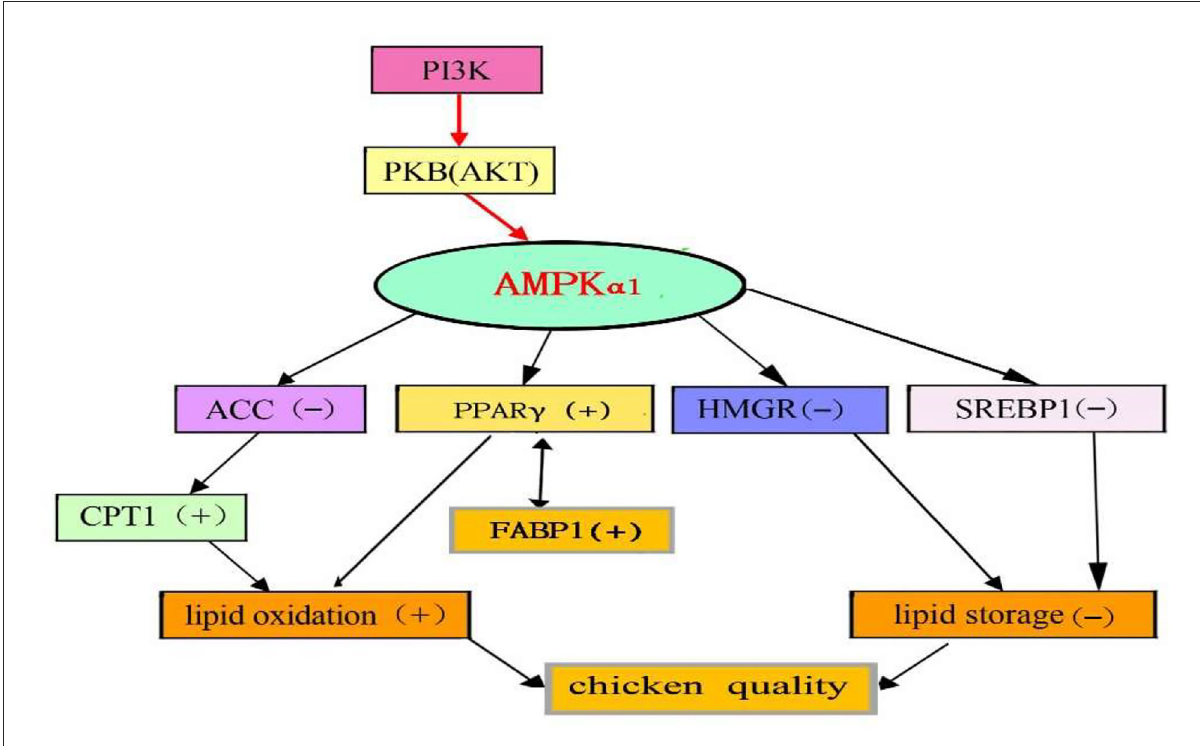
FIGURE3 Proposed model of AMPK actions on gene expressions in the breast muscle of chickens supplemented with quercetin [(–), down, ( + ), up] change.